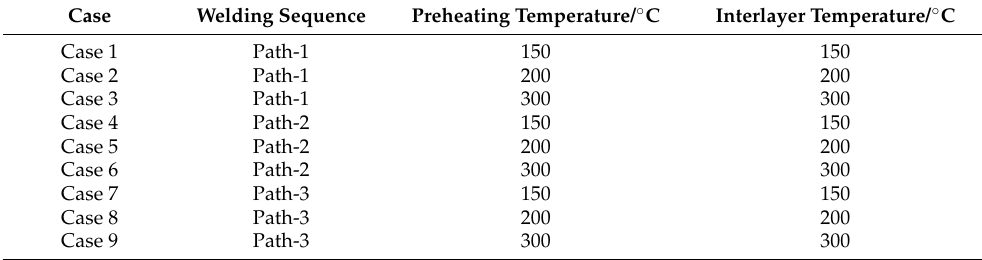
Table 3. Welding simulation